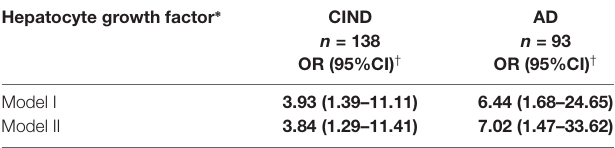
TABLE 2 | Association of HGF with CIND and AD.